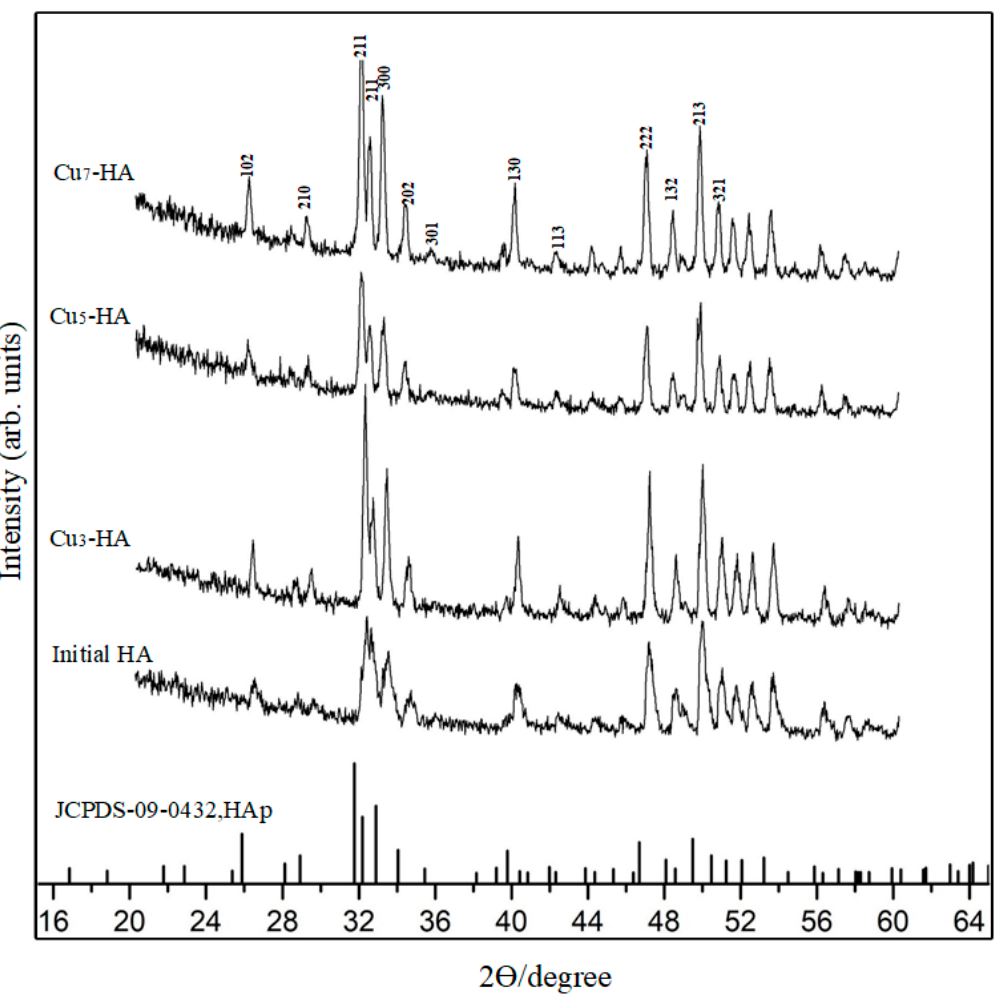
Figure 5. X-ray diffraction (XRD) spectra of HA, Cu 3 -HA, Cu 5 -HA, Cu 7 -HA scaffolds and standard spectra of HAp.